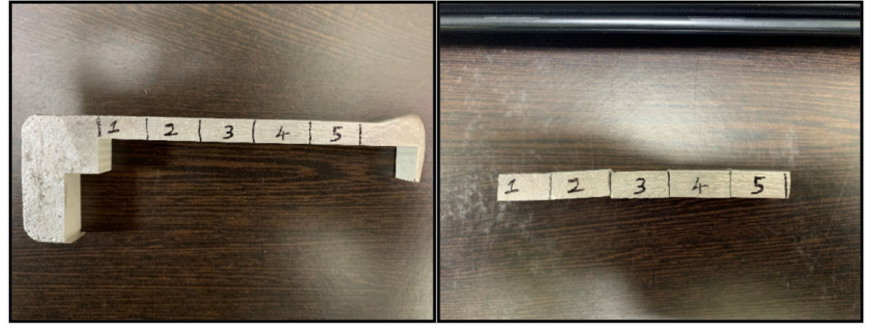
Figure 8. Samples for confirmation